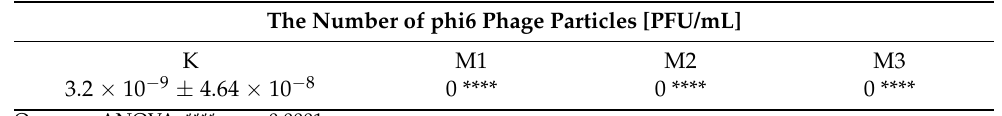
Figure 8. OD over time for host— P. syringe cells incubated with phi 6 bacteriophage particles after their incubation with the coatings (with M1, M2 and M3 mixtures of extracts). Phages particles were added when OD = 0.2, amount of phage MOI = 1. Table 8. The influence of coated, active films on bacteriophage